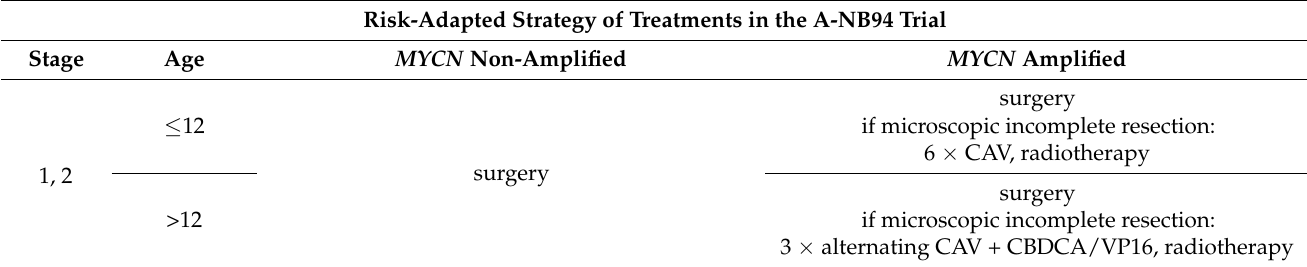
Table 1. Overview of the A-NB94 risk-adapted strategy of